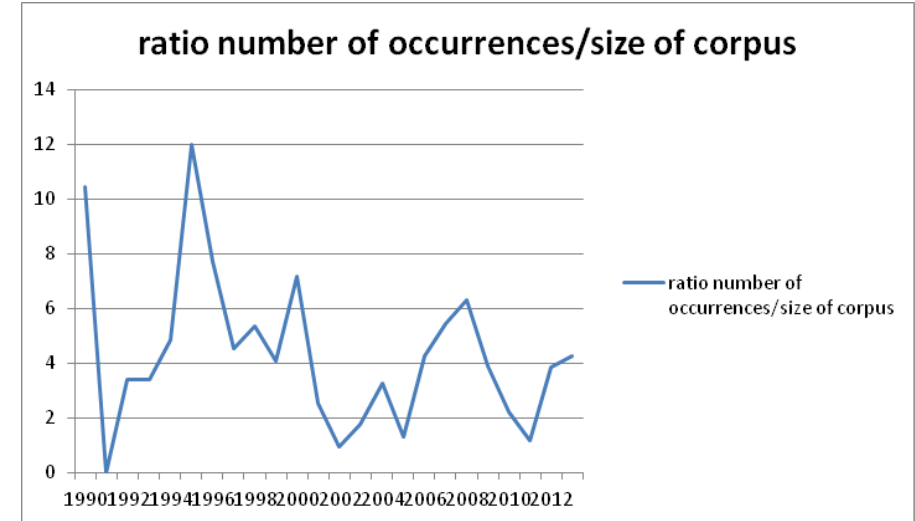
Figure 1: Development within the corpus